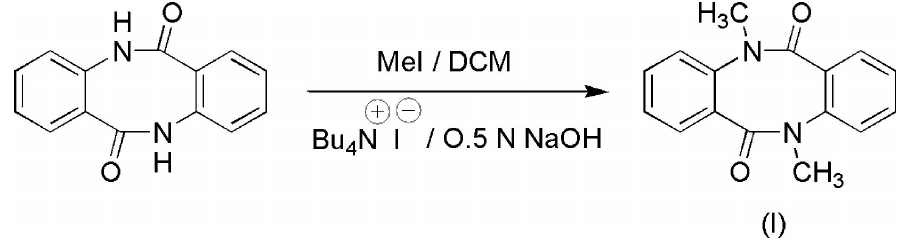
Figure 2 Synthetic scheme for the synthesis of